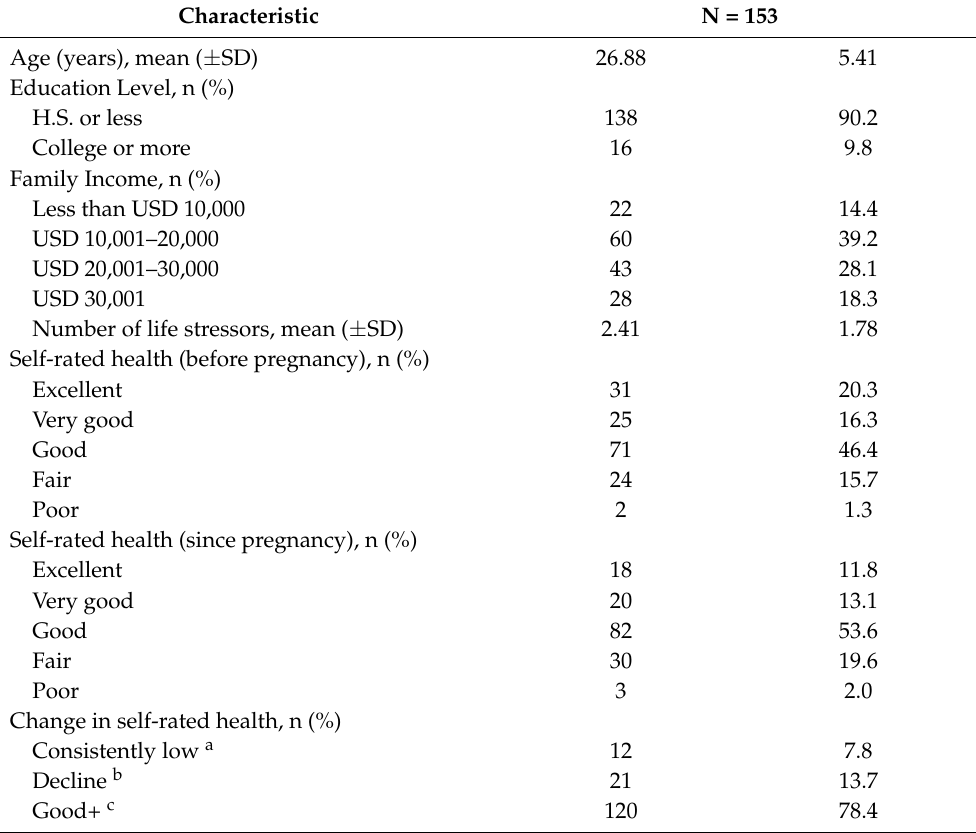
Table 1. Self-Reported Demographic and Health Characteristics of Participating Latina Women. Characteristic N = 153